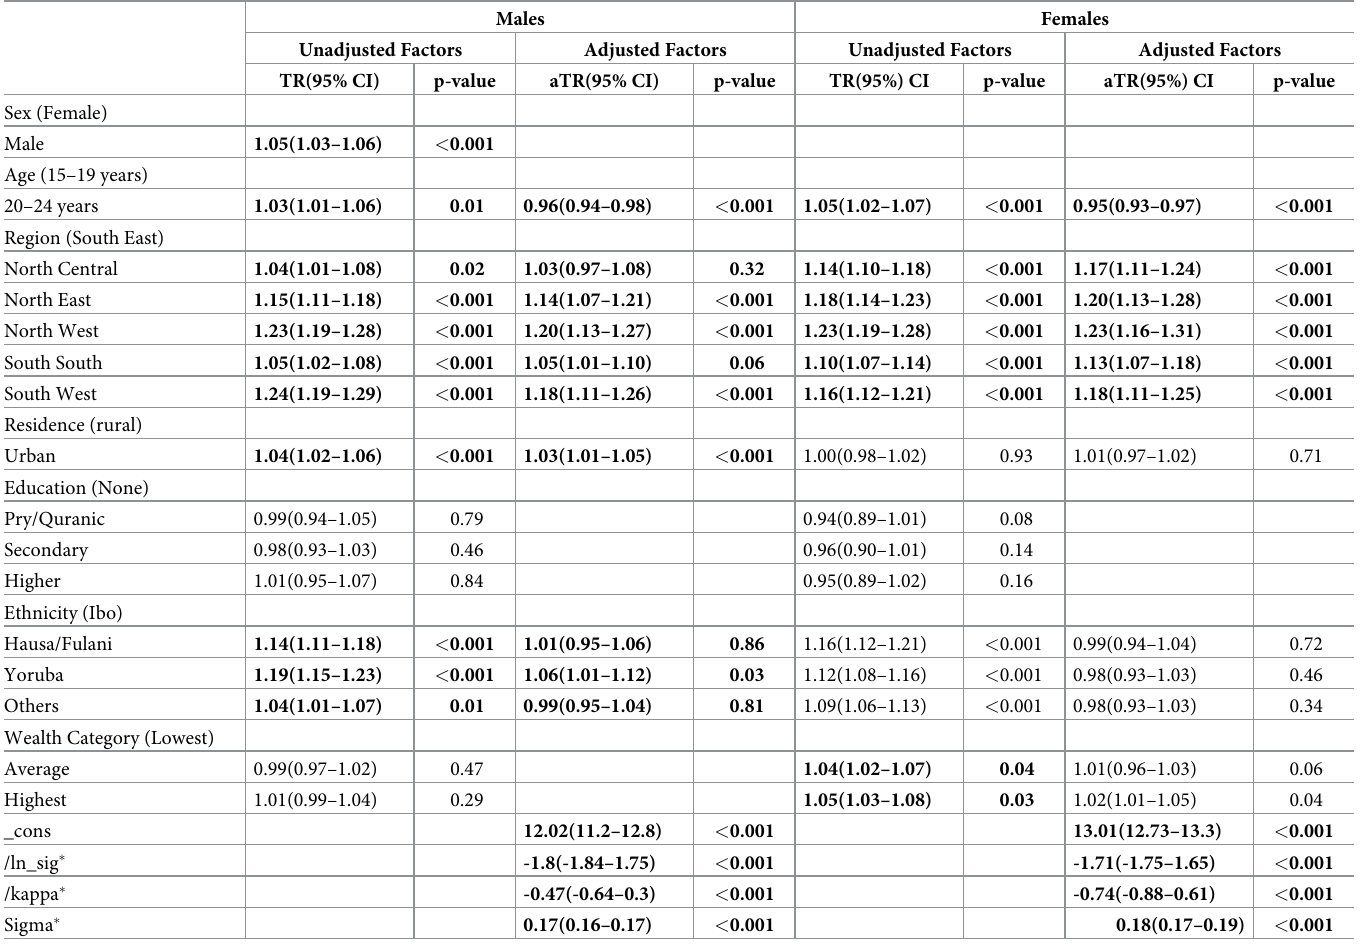
Table 4. Unadjusted and adjusted determinants of risk of pubarche among adolescents and emerging